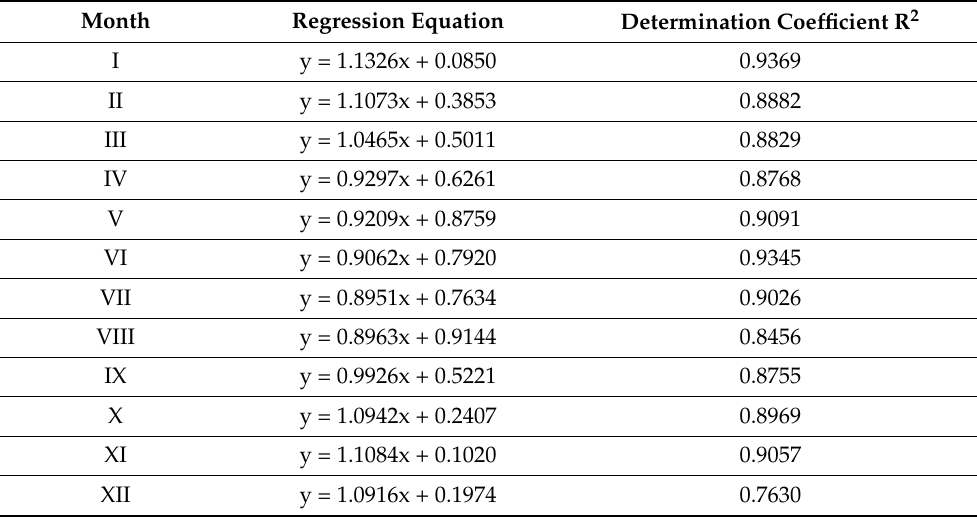
Table 4. Regression equations to reconstruct a multi-year sunshine duration for CSD3 (y) on the base of CS measurements (x) in Borucino,